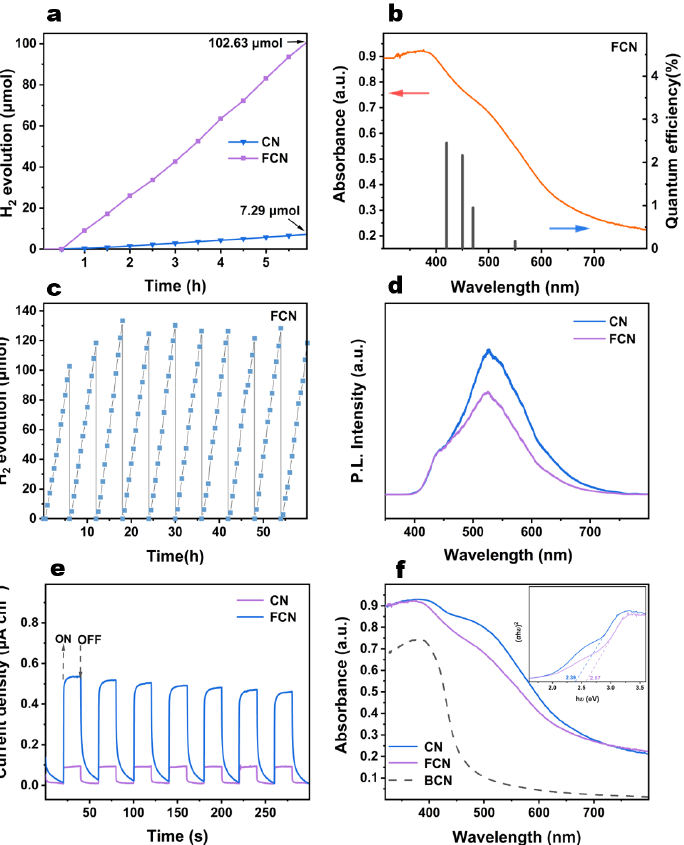
Figure 5. ( a ) Photocatalytic H 2 evolution of CN and FCN. ( b ) The AQY against the light absorption wavelength of FCN. ( c ) The H 2 evolution cycling plots for FCN through 60 h of operation. ( d ) PL spectra for CN and FCN. ( e ) Transient photocurrent responses of CN and FCN. ( f ) UV-vis diffuse reflectance spectra and plots of ( α h ν ) 2 vs. photon energy ( h ν ) of CN and